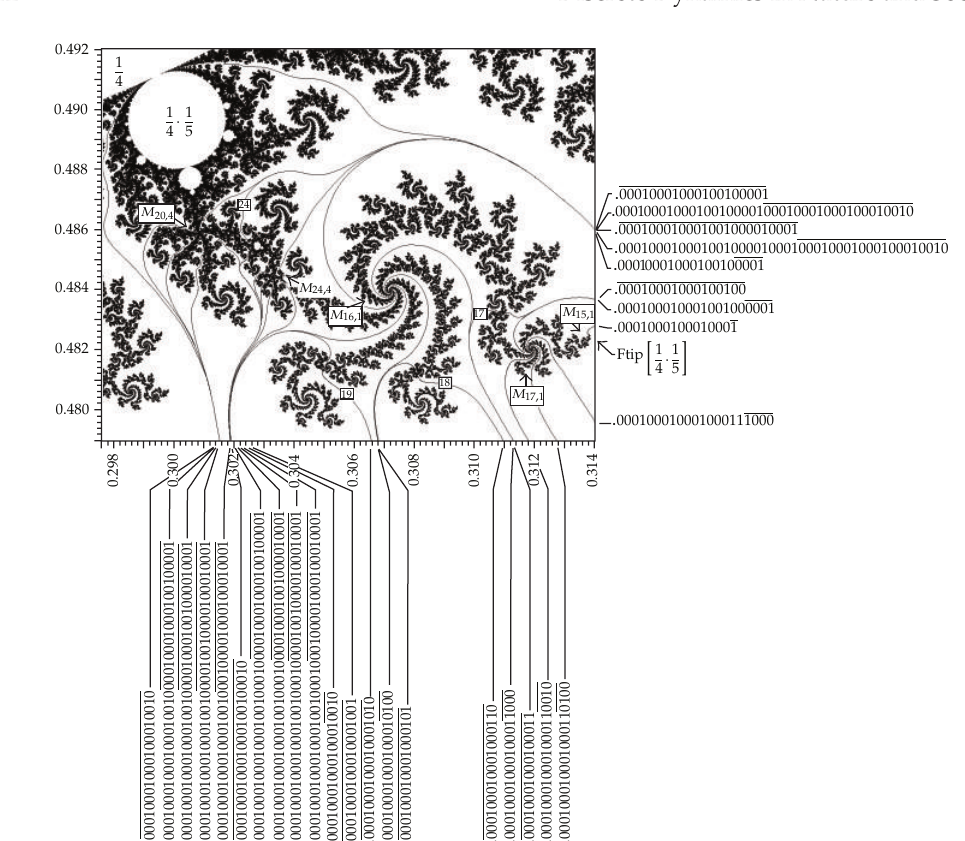
Figure 7: Magnification of the rectangle c of Figure 6 (cid:5) a (cid:6) , corresponding to shrub (cid:5)(cid:5) 1 / 4 (cid:6) · (cid:5) 1 / 5 (cid:6)(cid:6) .